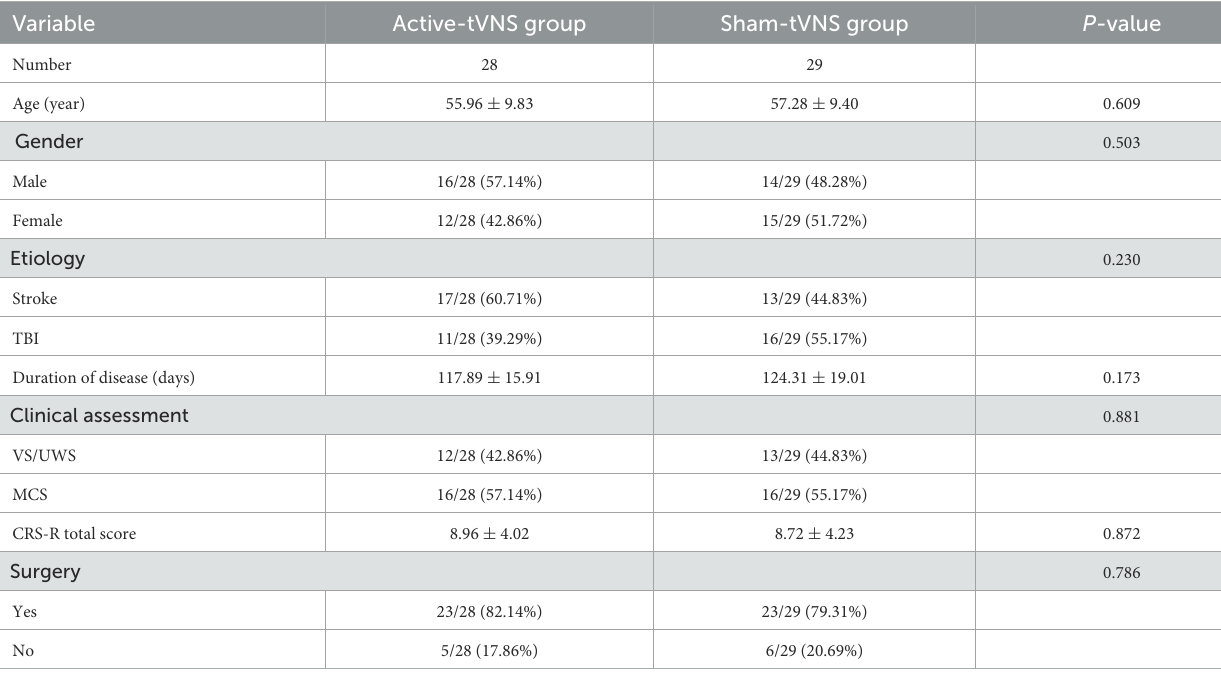
TABLE 2 Baseline demographic and clinical comparisons of subjects undergoing active or sham